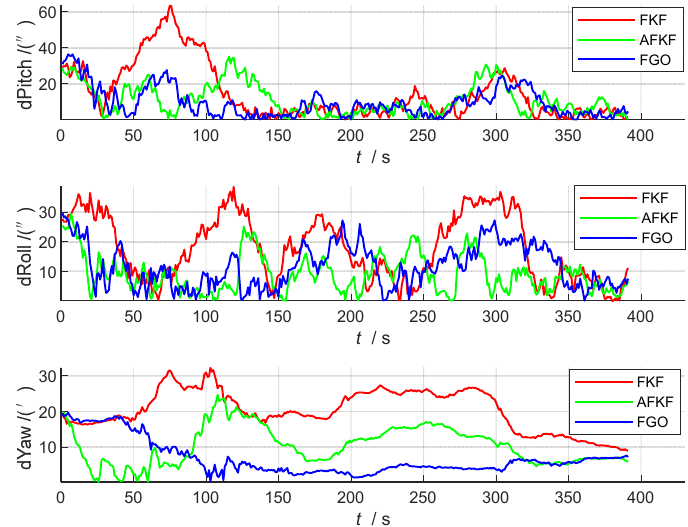
Figure 8. Comparison of attitude errors of different algorithms.